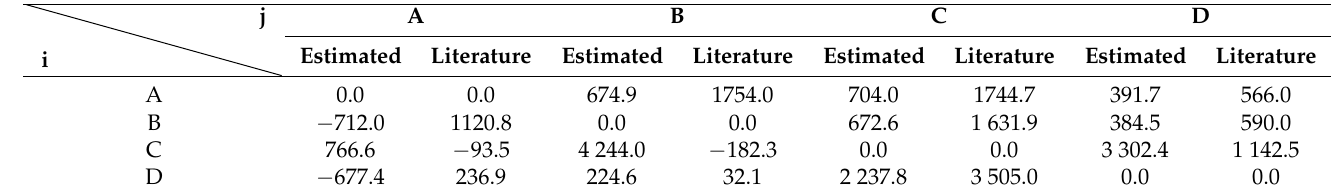
Table 5. NRTL thermodynamic parameters ∆ g ij for heterogeneous and pseudo-homogeneous at 313.15 K.